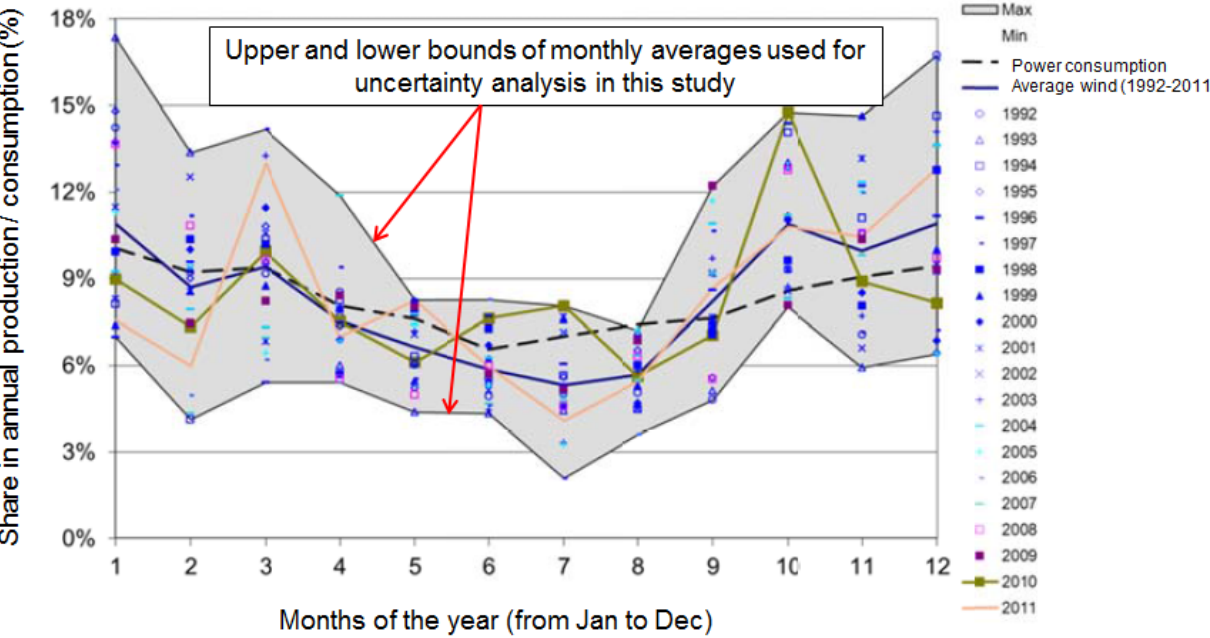
Figure A1. The recorded monthly averages of wind production in Finland 1992–2011, adopted with permission from